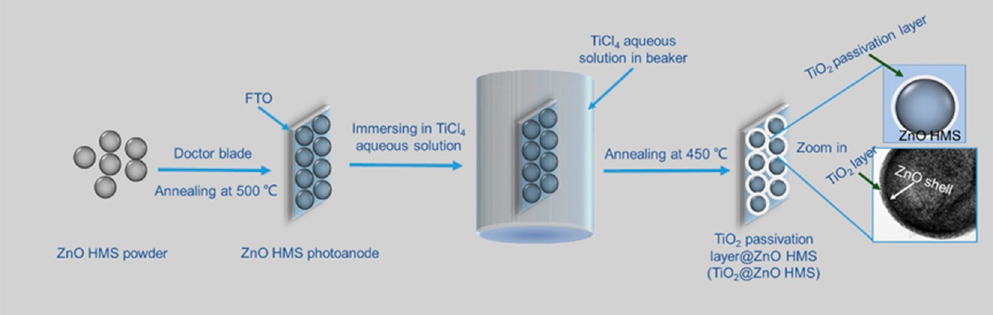
Figure 4. Illustration of TiO 2 -passivated ZnO HMS formation process.